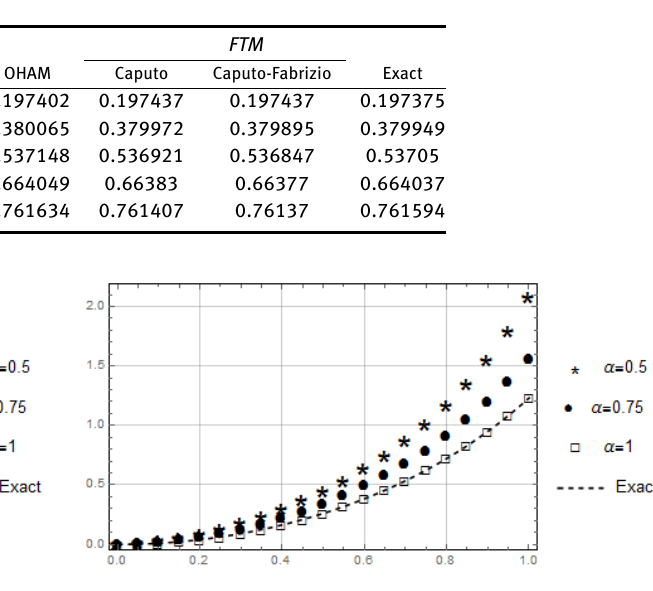
Table 2: Comparison of the numerical solutions of the equation in example 5.1 with α = 1 .